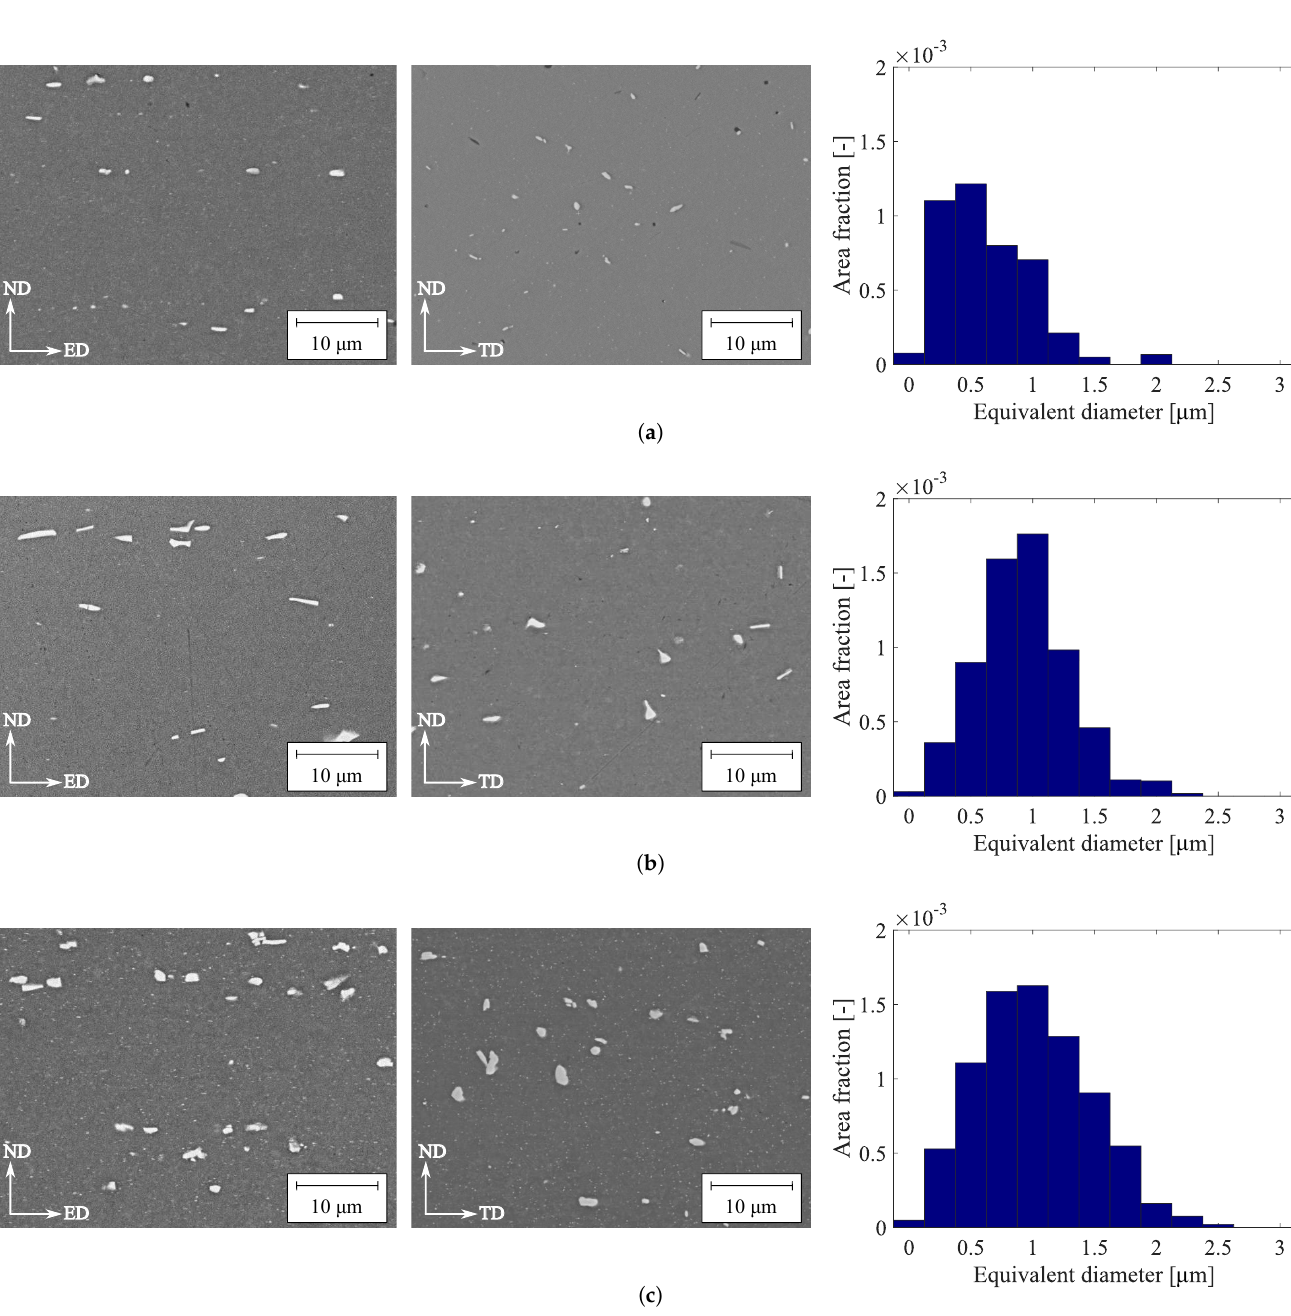
Figure 5. Results from the characterization of the constituent particles of the extruded alloys ( a ) AA6061, ( b ) AA6063 and ( c ) AA6110. The figure shows images of constituent particles in the alloys (two leftmost columns) along with their respective particle size distribution plots (rightmost column) in terms of area fraction of constituent particles versus equivalent diameter. The bar plots are based on the images in the ND-TD plane, and each bar represents a 0.25 µ m interval of the equivalent diameter. Please note that particles with an equivalent diameter smaller than 0.2 µ m were omitted to avoid analyzing